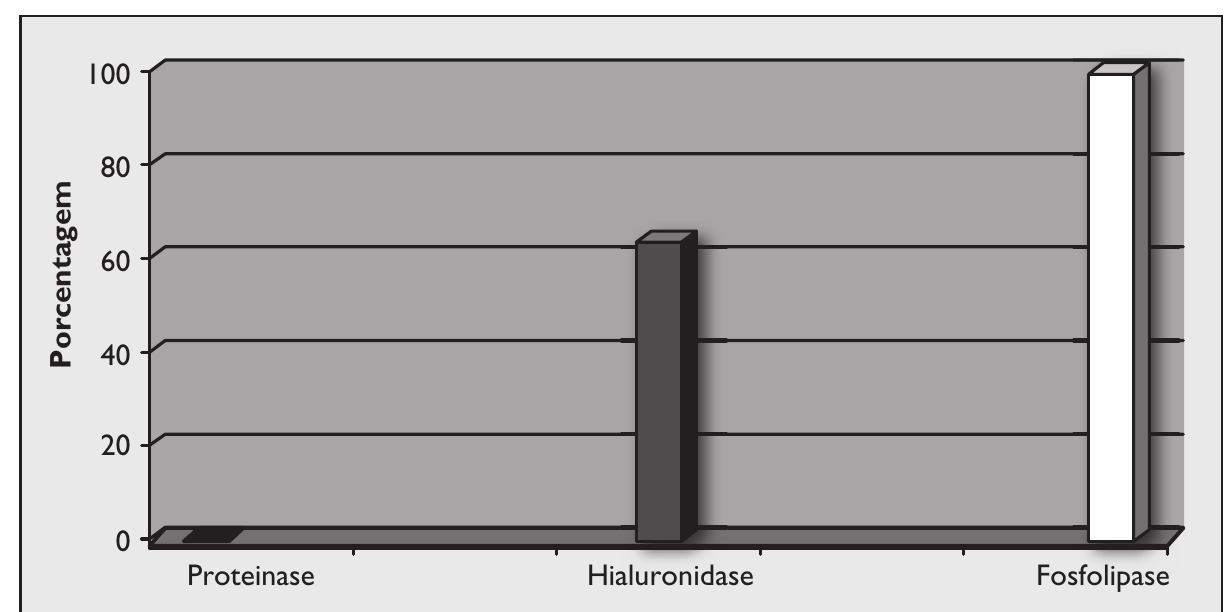
Figura 3 – Atividades enzimáticas de Candida albicans isoladas de lactantes com mastite no